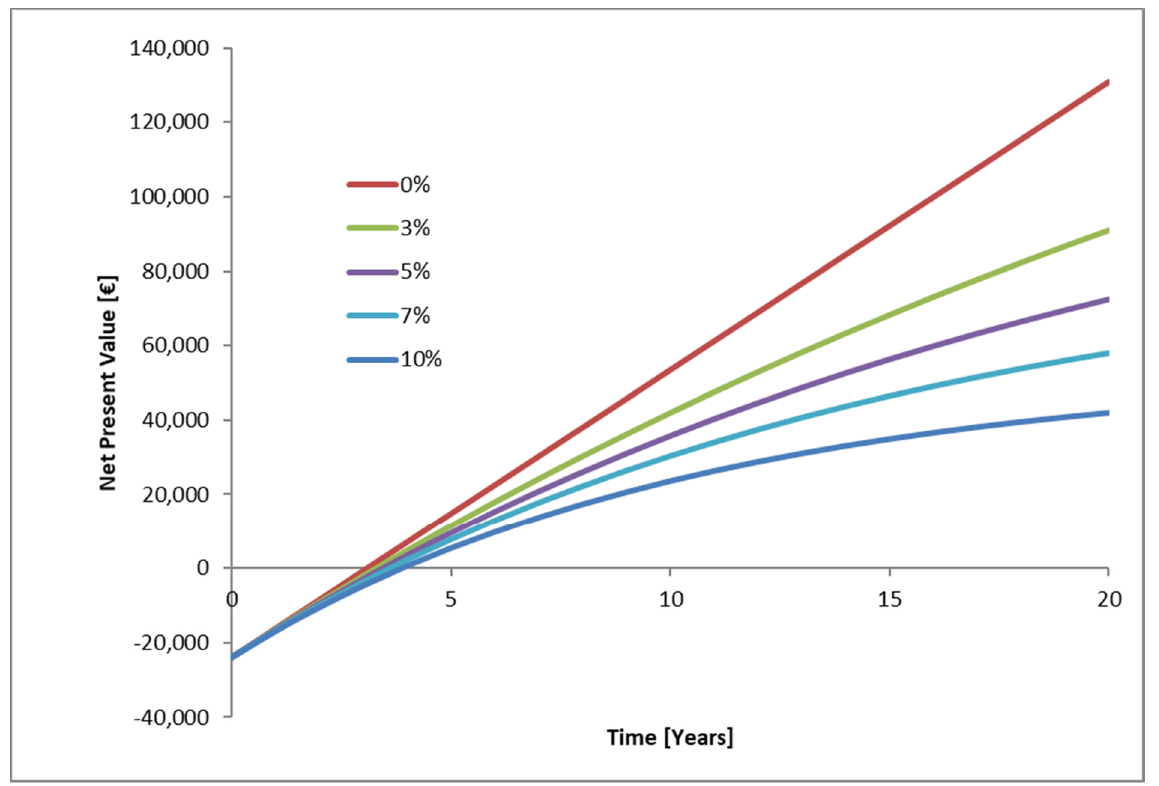
Figure 17. Monthly photovoltaic production.